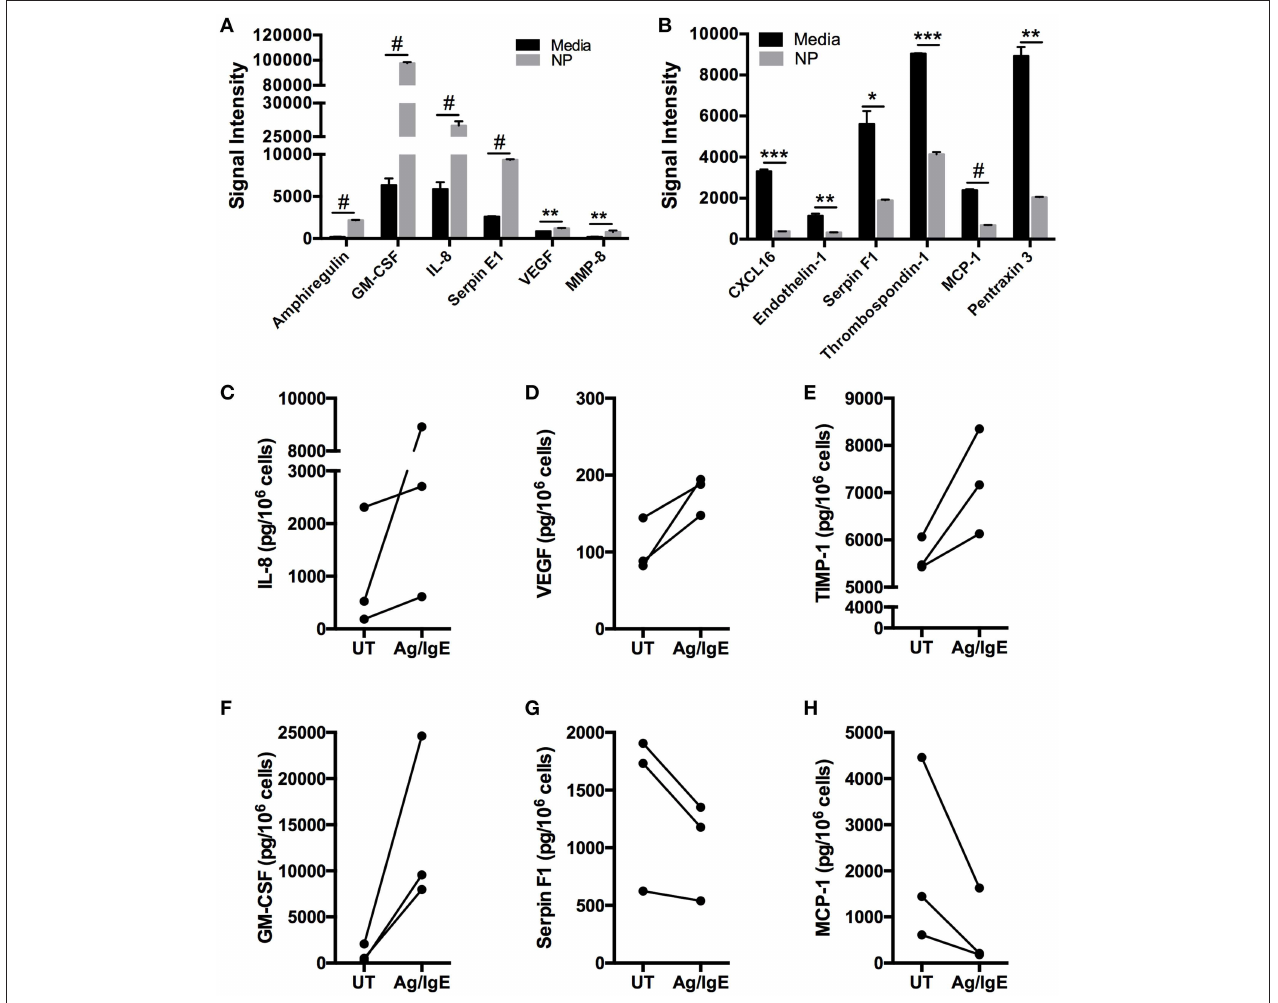
FIGURE 4 | Fc ε RI crosslinking enhances and inhibits human mast cell secretion of angiogenesis-related factors. Human skin mast cells were sensitized with anti-DNP IgE and then activated with DNP-HSA (100ng/ml) for 24h in serum-free media containing SCF and SBTI. The cell-free supernatants were analyzed with the Human Angiogenesis Proteome Profiler TM Array (R&D Systems) (A,B) . The graph bars represent the mean signal intensity ± S.E.M. ( n = 4) obtained from membrane arrays incubated with media from individual mast cell cultures prepared from skin tissue of different donors. In separate experiments with different mast cell cultures, media was collected and analyzed with ELISA for IL-8 (C) , VEGF (D) , TIMP-1 (E) , GM-CSF (F) , Serpin F1 (G) , and MCP-1 (H) . The data points in (C–H) represent values obtained from mast cells isolated from individual skin tissue of three different donors. Significance was determined with Student’s t -test. * p < 0.05; ** p < 0.01; *** p < 0.01; # p <